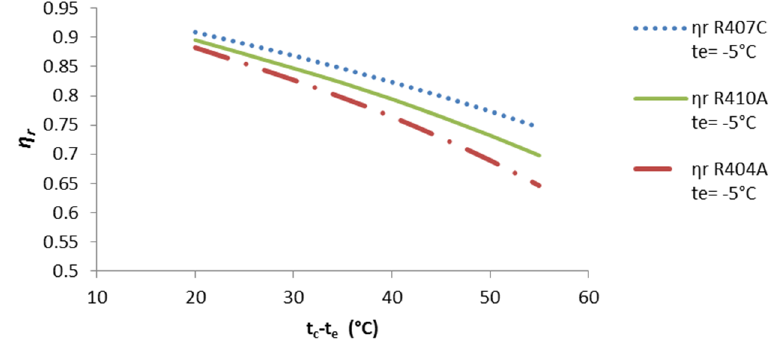
Figure 6. Thermodynamic efficiency of R134a, R417A, and 427A, t c = 65 °C [14–16].